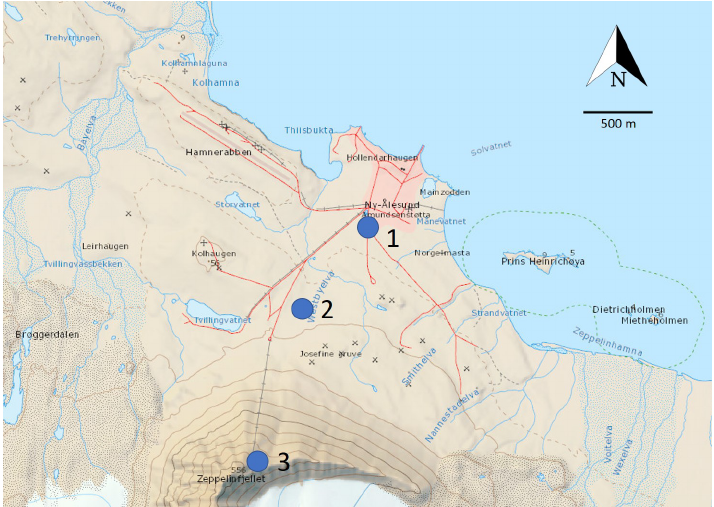
Figure 1. Site map of Ny-Ålesund. The locations of the Raman Lidar (1), the Gruvebadet Station (2) and the Zeppelin Station (3) are marked in the